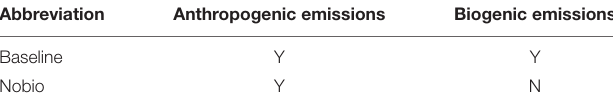
TABLE 2 | CMAQ sensitivity